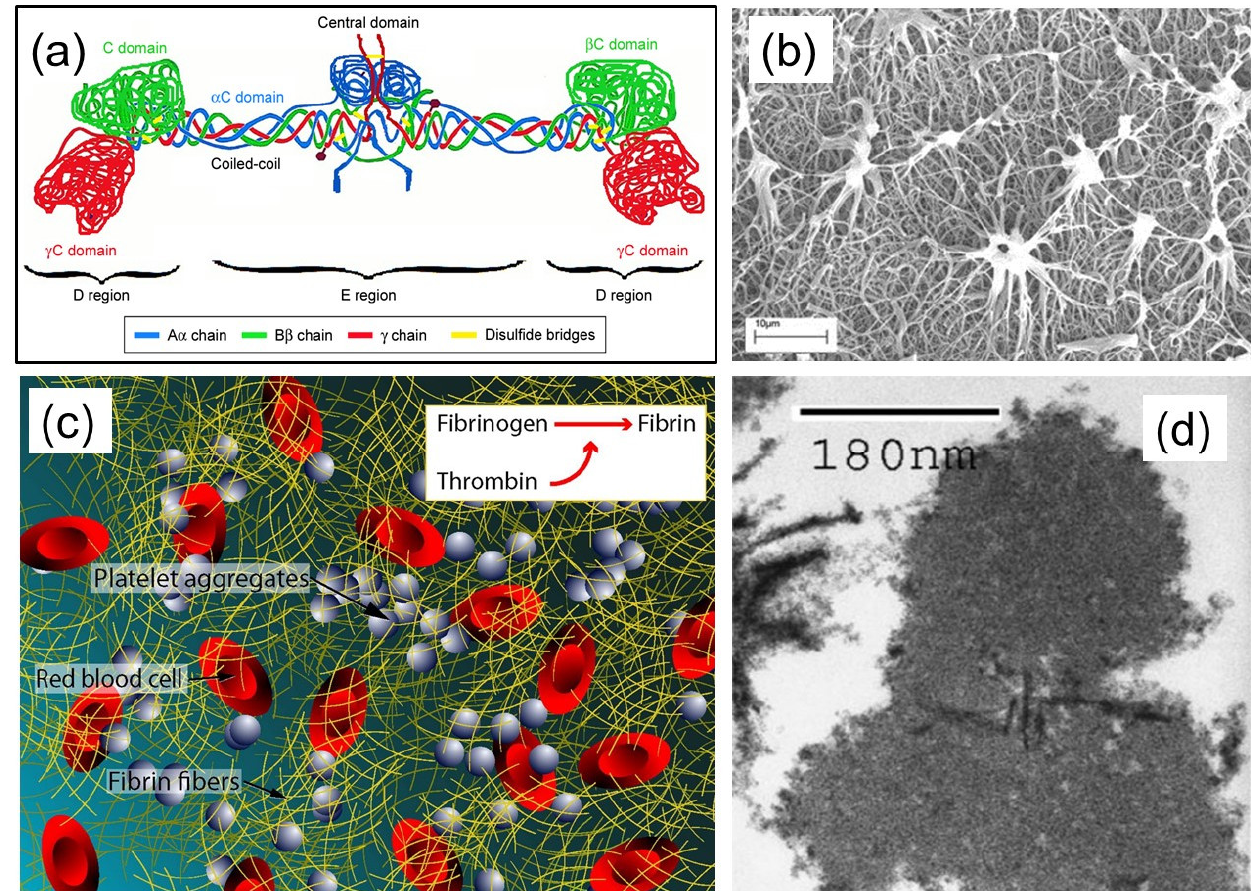
Figure 1. ( a ) Fibrinogen structure. Aα chains are shown in blue, Bβ chains are shown in green, and γ chains are shown in red. Disulfide bridges stabilizing the coiled-coil regions are shown in yellow. Reprinted/adapted with permission from Ref. [5]. 2017, DovePress. ( b ) SEM image of fibrin clots formed using high and low thrombin concentrations after 10 min of lysis after the addition of tissue-type plasminogen activator (tPA) to the surface of the clot. Reprinted/adapted with permission from Ref. [6]. 2011, American Society of Hematology. ( c ) Image of how fibrin fibers from fibrinogen act as glue and a scaffold for the grouping of red blood cells, platelets, and other plasma proteins within a fibrin clot. Reprinted/adapted with permission from Ref. [7]. 2017, Elsevier. ( d ) TEM image (90,000×) of the cross-section of a fibrin fiber. Reprinted/adapted with permission from Ref. [8]. 2004, Elsevier.